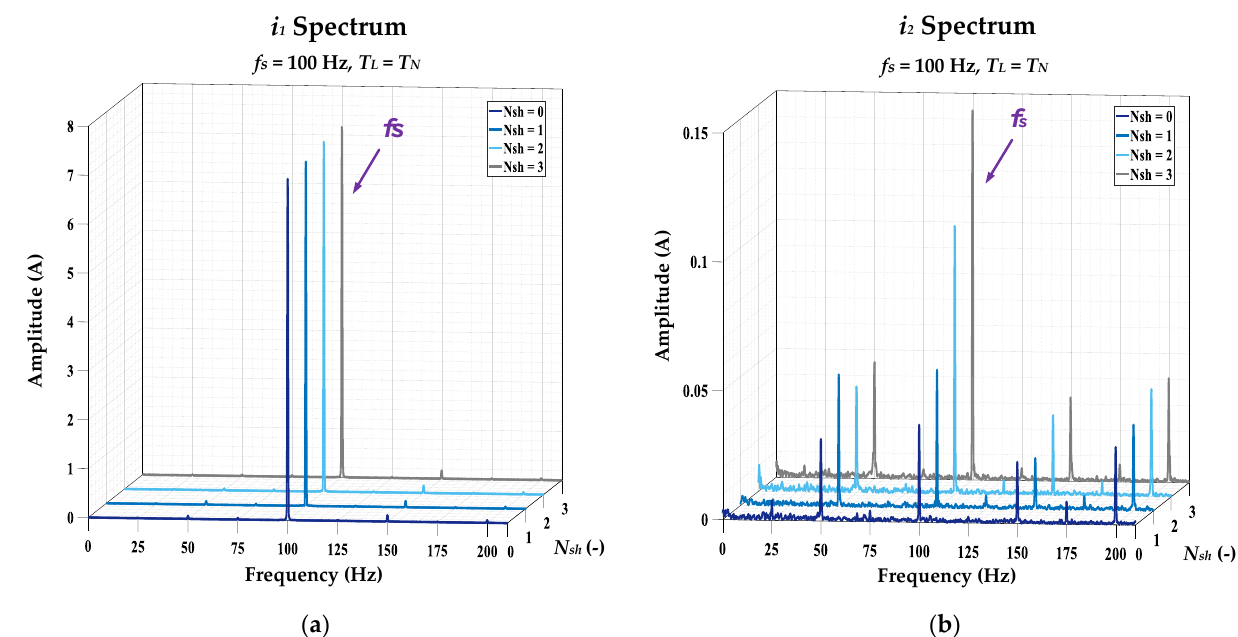
Figure 3. The impact of shorted turns number in the PMSM stator winding on the FFT spectrum of the positive ( a ) and negative ( b ) phase current sequence component: f s = 100 Hz , T L = T N .